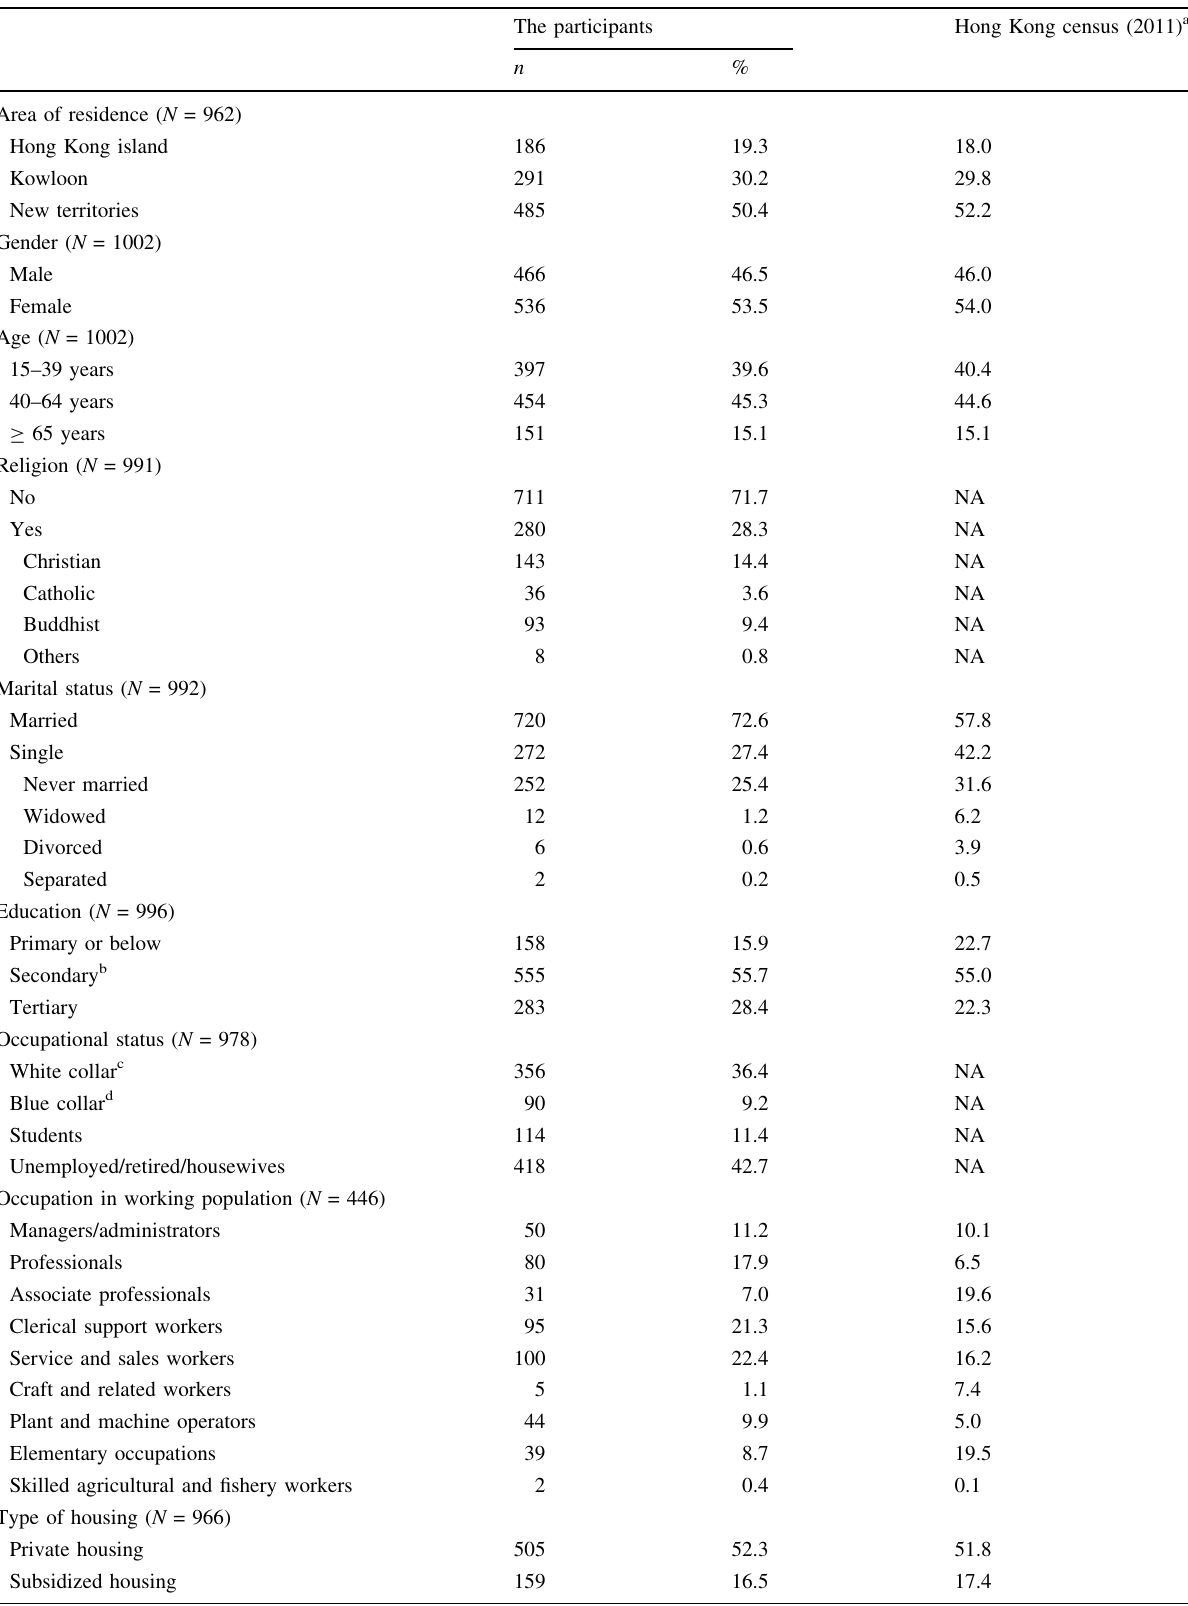
Table 1 Characteristics of the participants in the risk perception of climate change health impact survey in Hong Kong The